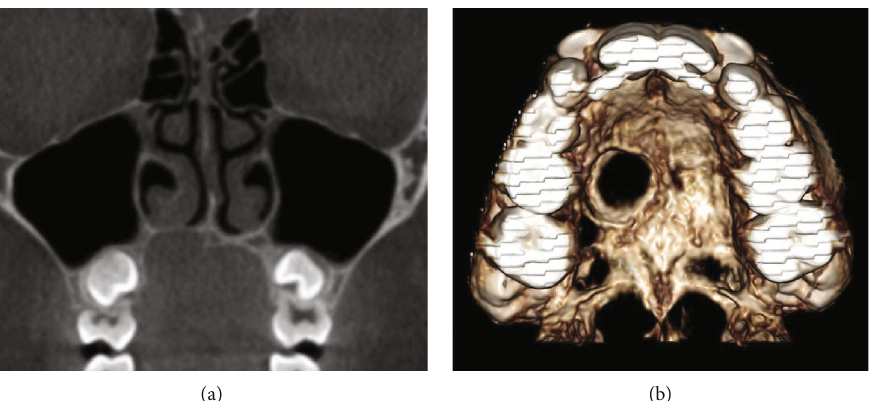
Figure 1: Cropped cone beam CT images of the maxilla. (a) Coronal image and (b) 3D reconstruction, showing concavity of the right hard palate, thinning, and superior displacement of fl oor of nasal cavity.